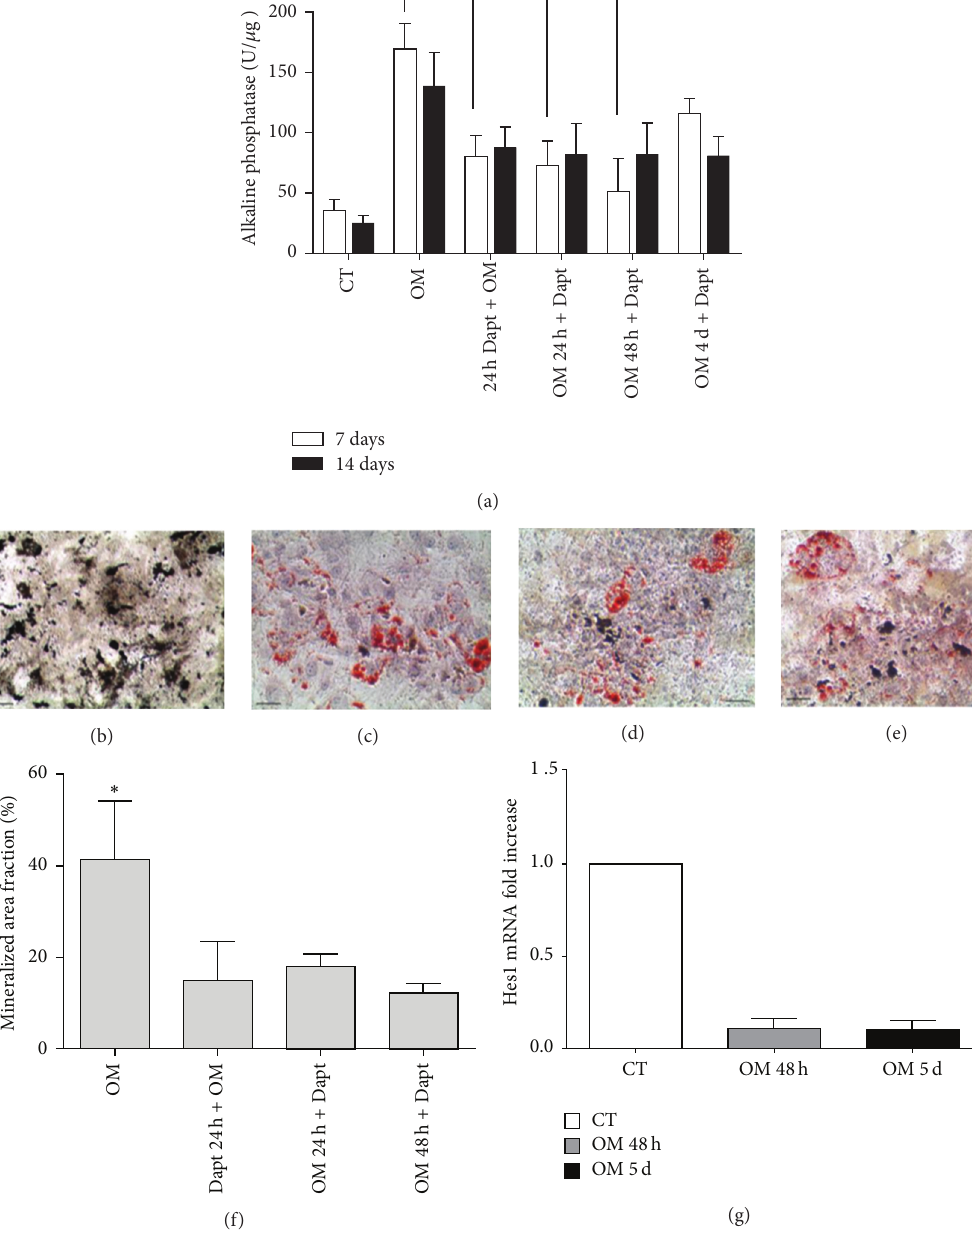
Figure 6: PS1/ 𝛾 -secretase inhibition impairs BMSCs osteogenic differentiation. BMSCs were osteoinduced in the presence of Dapt, added either 24 hours before OM (24 h Dapt + OM) or at 24h (OM 24 h + Dapt), 48 h (OM 48 h + Dapt), or 4 days after OM (OM 4 days + Dapt). (a) Alkaline phosphatase activity measured after 7 and 14 days. Graph represents the mean ± SD of 6 independent experiments. (b–e) Von Kossa and Oil Red O double staining. (b) Control osteoinduced, (c) 24 h Dapt + OM, (d) OM 24 h + Dapt, and (e) OM 48 h + Dapt. Scale bars = 100 𝜇 m. Data are representative of 4 independent experiments. (f) Quantification of total mineralized area revealed by Von Kossa staining. Data represent mean ± SD of 3 independent experiments. ∗ 𝑝 < 0.05 . (g) Analysis of Hes-1 mRNA in BMSCs osteoinduced for 48 h and 5 days. Bars represent the mean ± SD of 3 independent experiments performed in